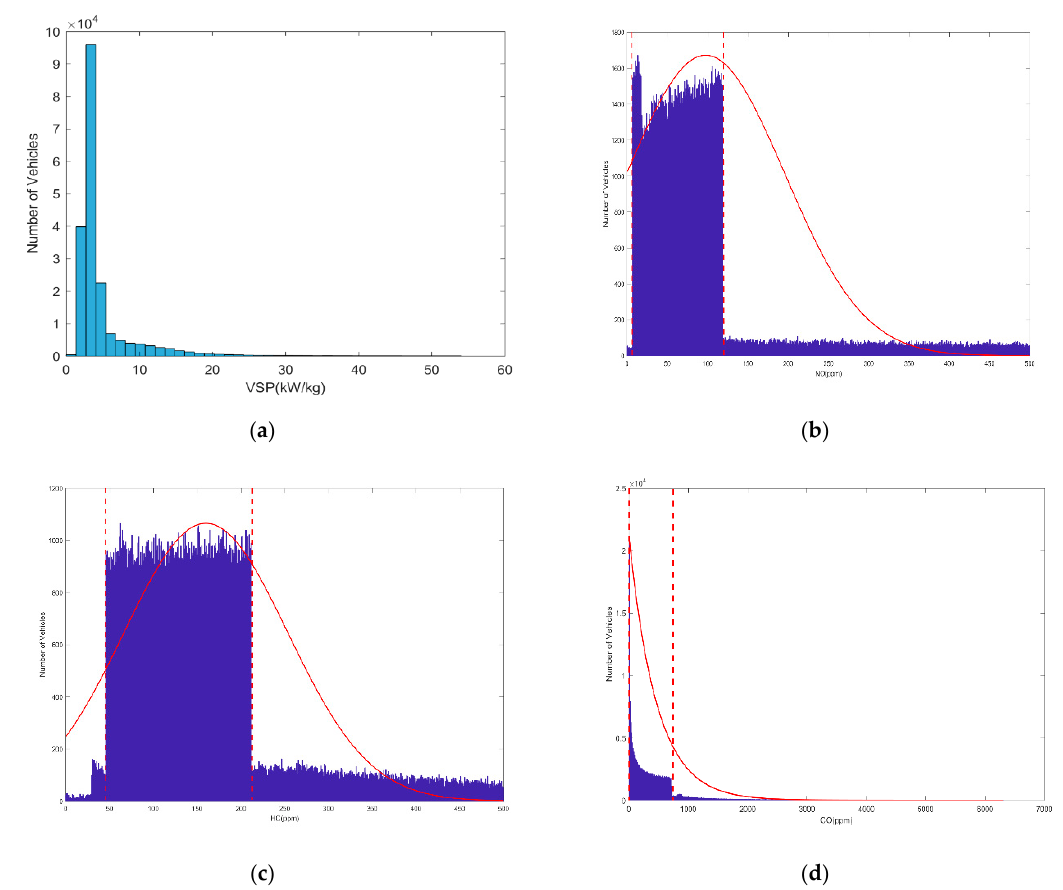
Figure 3. The histogram of vehicle specific power (VSP) and three main types of emissions collected in 192,097 datasets: ( a ) VSP; ( b ) NO; ( c ) HC; ( d ) CO.